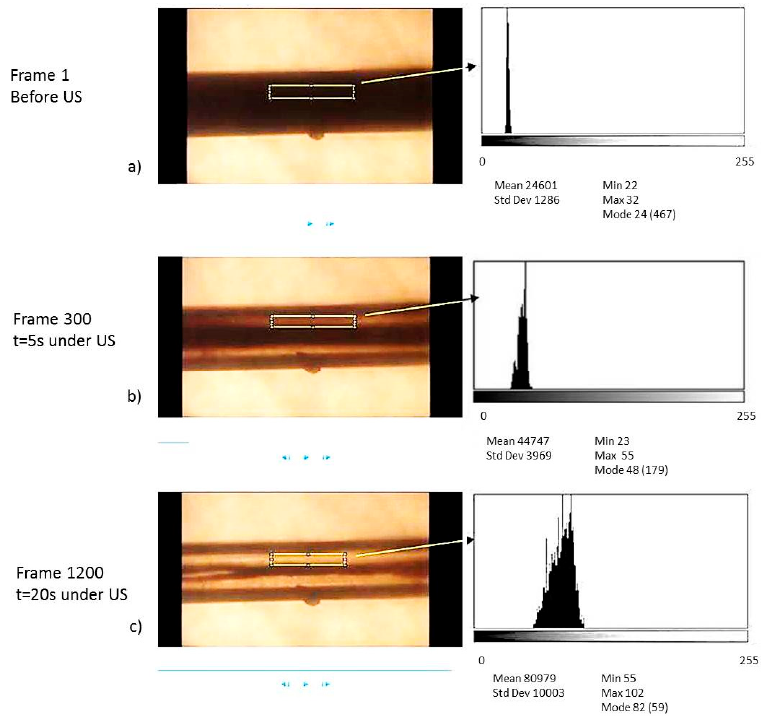
Figure 3. Three frames extracted from a movie of blood exposed to ultrasounds in the capillary ( a ) before the acoustic actuation; ( b ) at 5 s of acoustic exposure; ( c ) 20 s exposed to the ultrasounds at f = 1.153